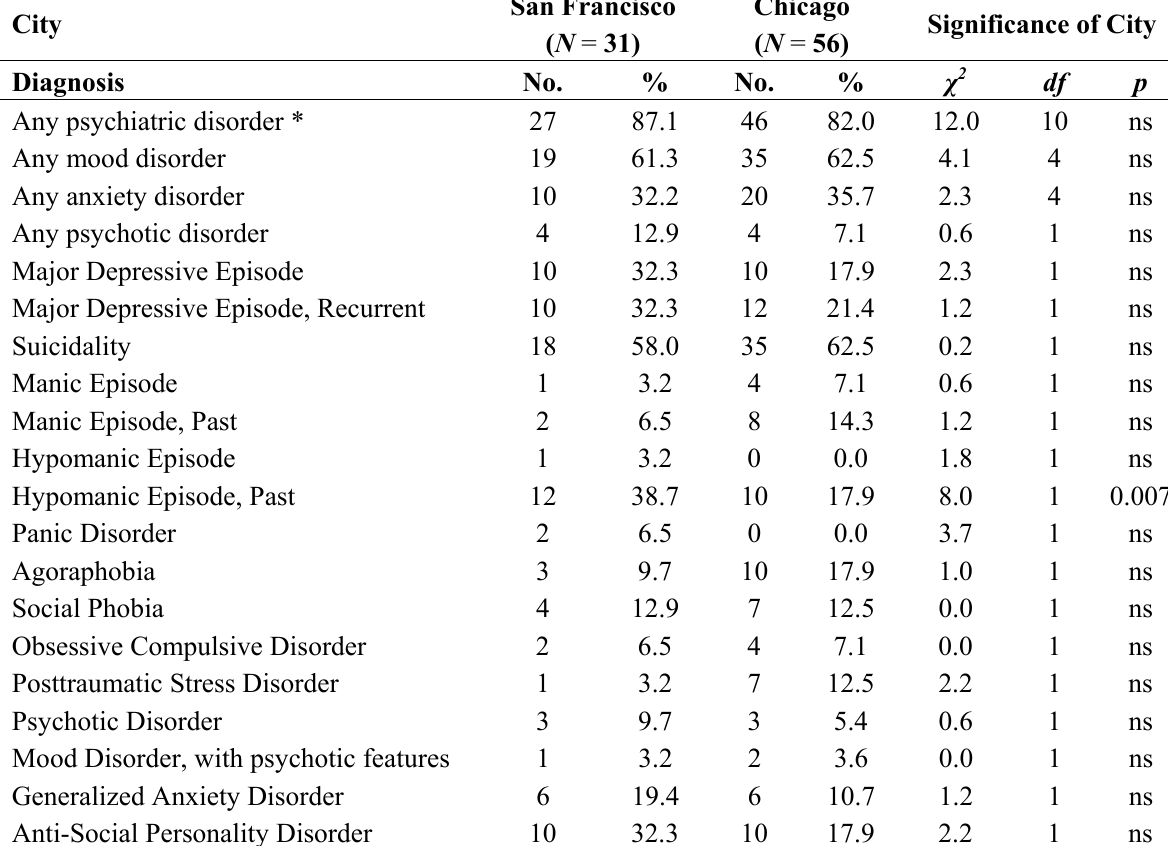
Table 2. Mini International Neuropsychiatric Interview (M.I.N.I.) diagnoses.